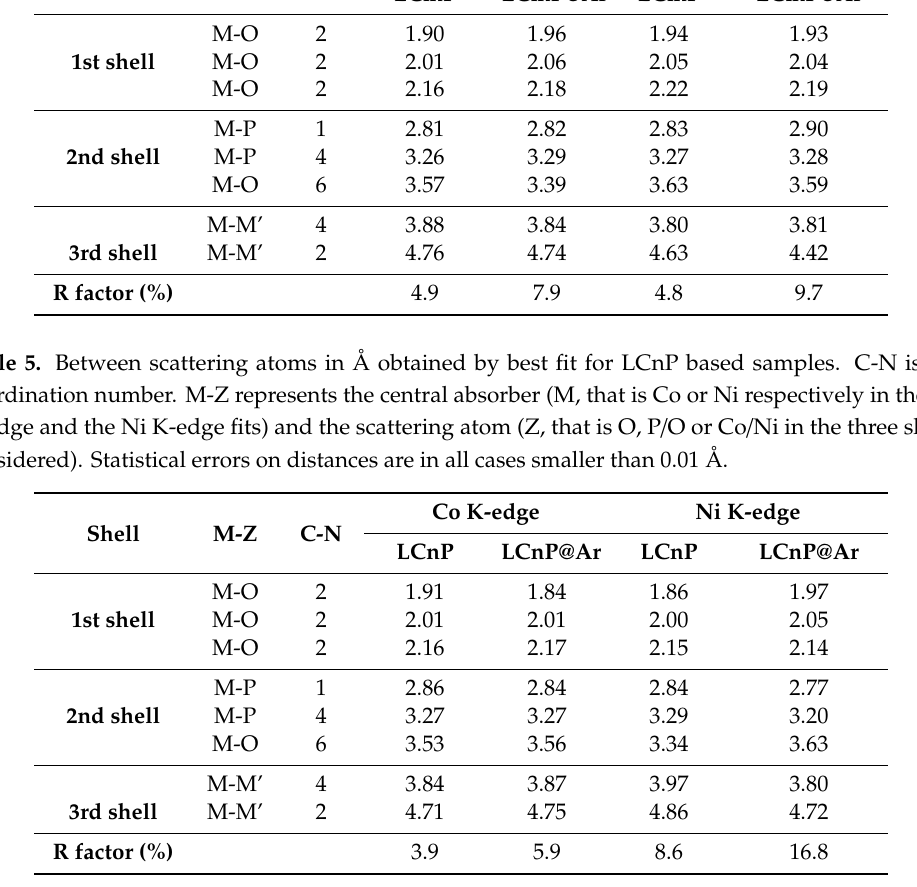
Table 4. Between scattering atoms in Å obtained by best fit for LCmP based samples. CN is the coordination number, M-Z represents the central absorber (M, that is Co or Mn respectively in the Co K-edge and the Mn K-edge fits) and the scattering atom (Z, that is O, P / O or Co / Mn in the three shells considered). Statistical errors on distances are in all cases smaller than 0.01 Å. Shell M-Z C-N